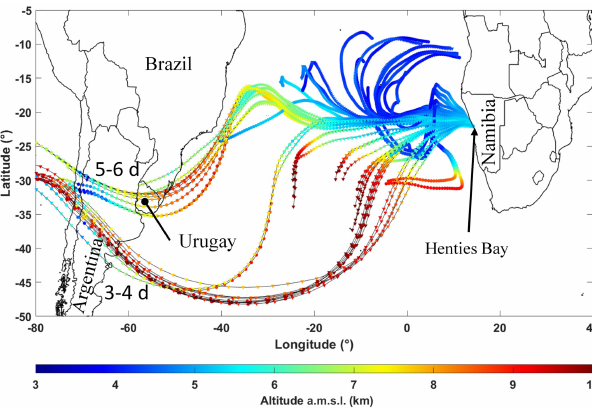
Figure 16. The 6d isentropic back trajectories starting over Hen- ties Bay on 6 September at 12:00UTC. They are computed by the HYSPLIT model (courtesy of NOAA Air Resources Laboratory; http://www.arl.noaa.gov, last access: 23 November 2019) in ensem- ble mode. The time to arrival above the South America is indicated. The altitude of back trajectories along the route is given by the colour